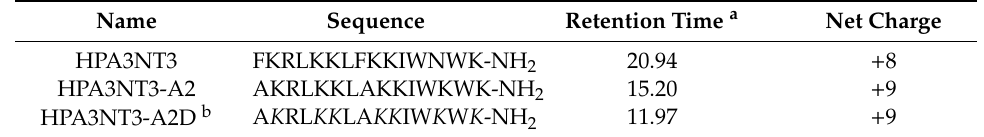
Table 1. Amino acid sequences, retention time, and net charge of HPA3NT3 and its analogue